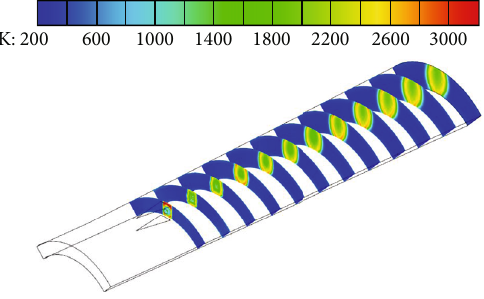
Figure 23: Distribution of temperature.